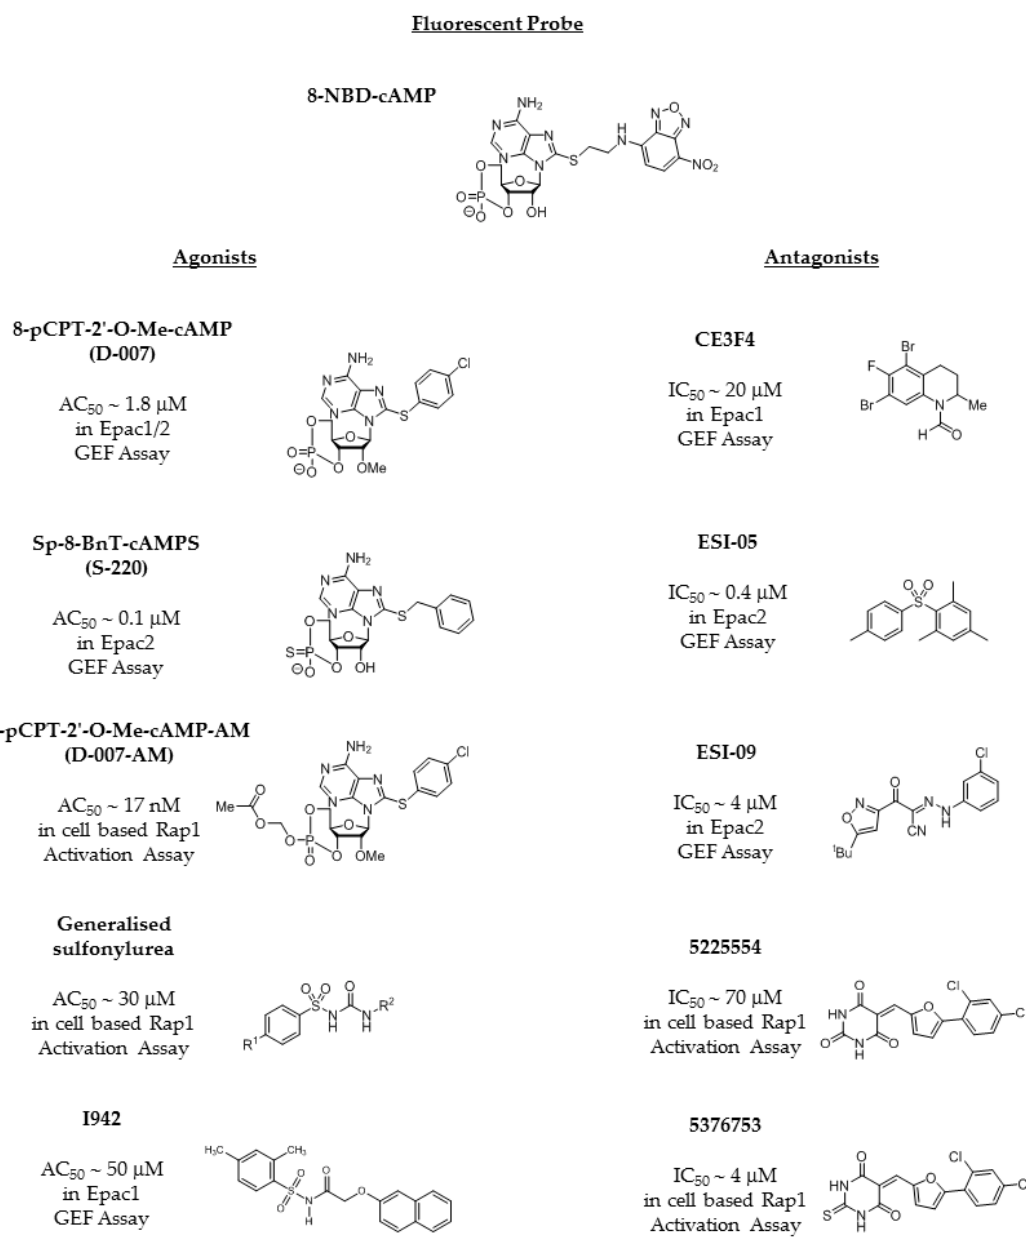
Figure 4. Chemical structures of existing EPAC-selective agonists and antagonists together with the cyclic analogue AMP analogue fluorescent probe molecule, 8NBD-cAMP.